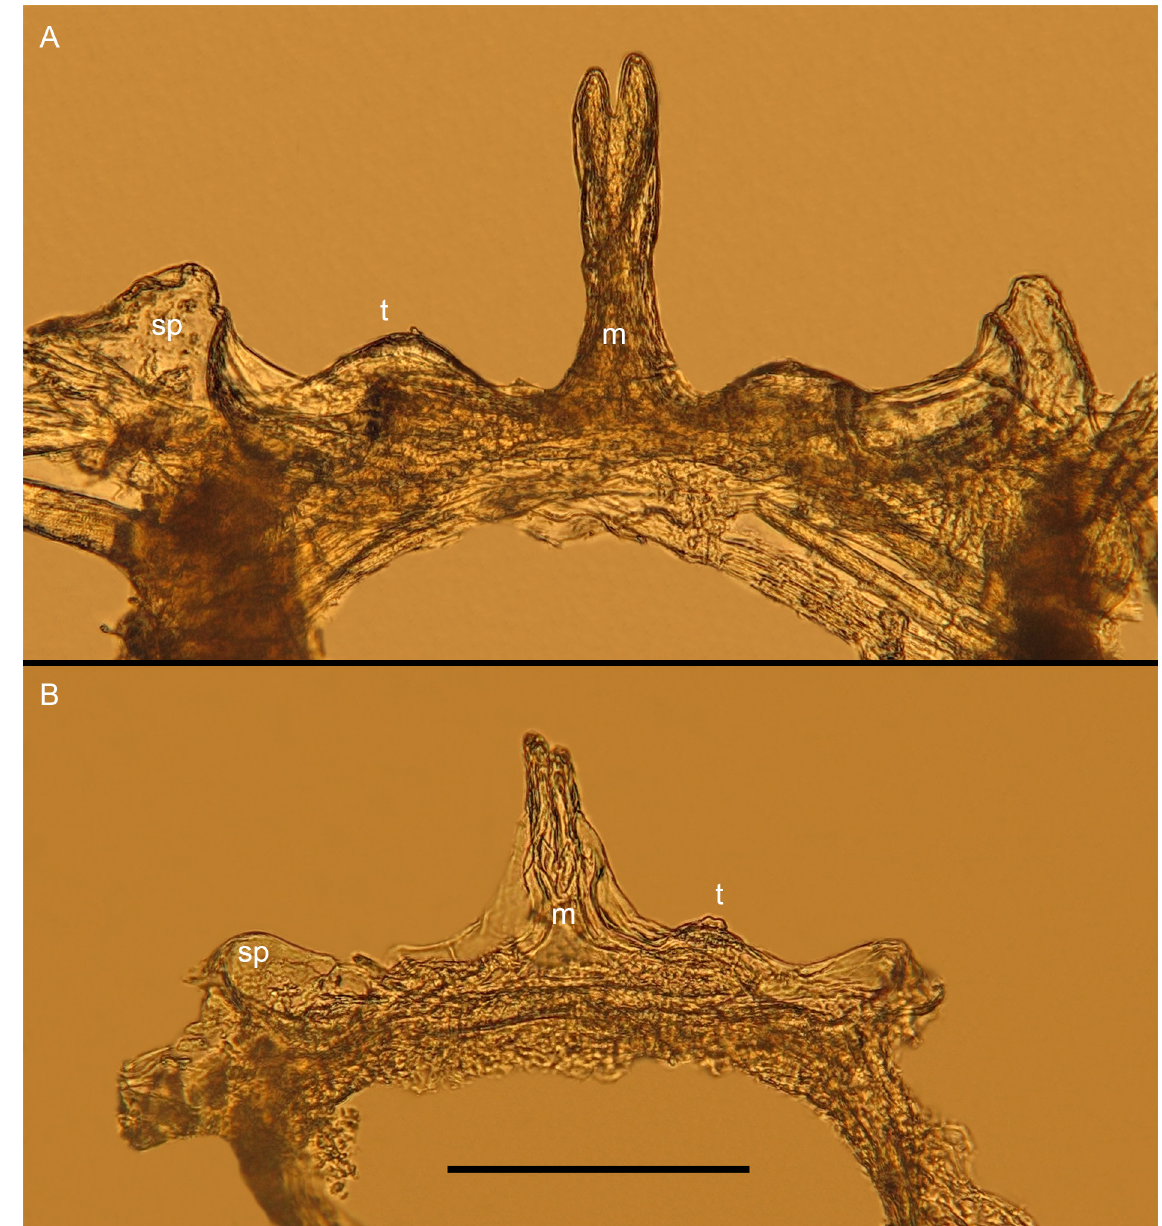
Fig. 9. Posterior gonopods. A . Biokoviella mauriesi Mršić, 1992, ♂ from the Lovricia 3 Pit. B . Biokoviella mosorensis Antić & Dražina sp. nov., ♂, holotype. Abbreviations: see Material and methods. Scale line = 0.2